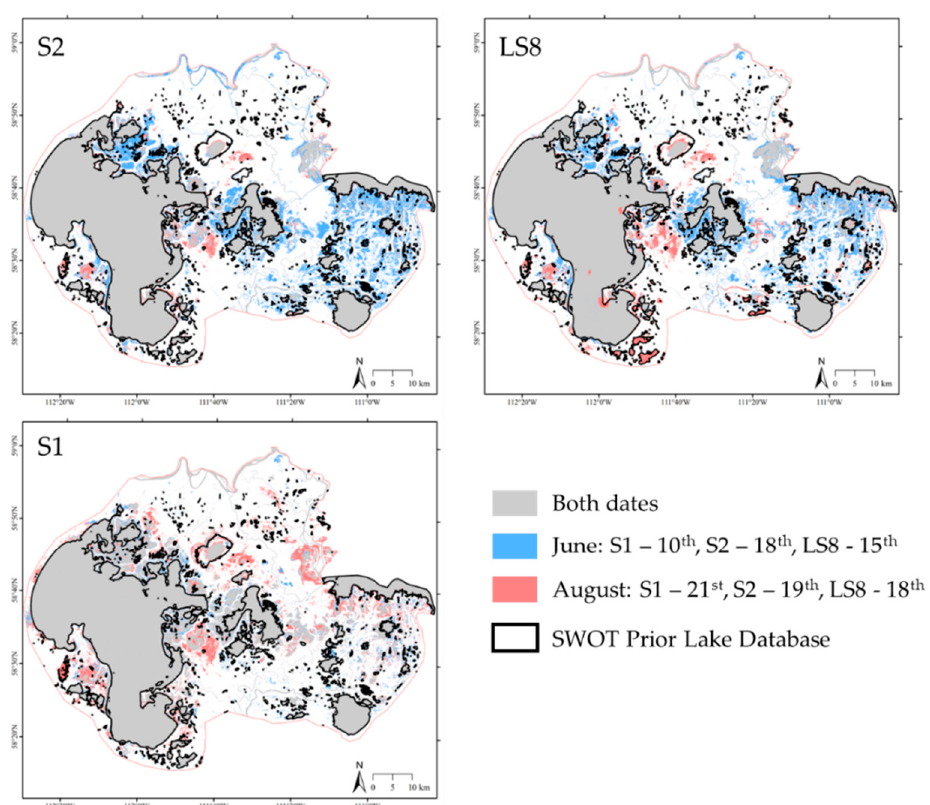
Figure 7. 2020 water surface area comparison between June and August for Sentinel-1 (S1), Sentinel-2 (S2) and Landsat-8 (LS8) where grey shows area of open water seen at both dates, blue shows open water seen in June only and red shows open water seen in August only. SWOT mission Prior Lake Database is also shown in black contour